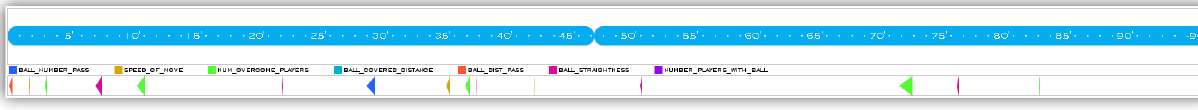
Figure 9. Derived moves from initial classification below the timeline. One can observe that this team seems to be focusing on fast and straight counter attacks, since the green feature (the amount of overcome players), the yellow feature (the speed of the move) and the magenta feature (the straightness of the ball) are very